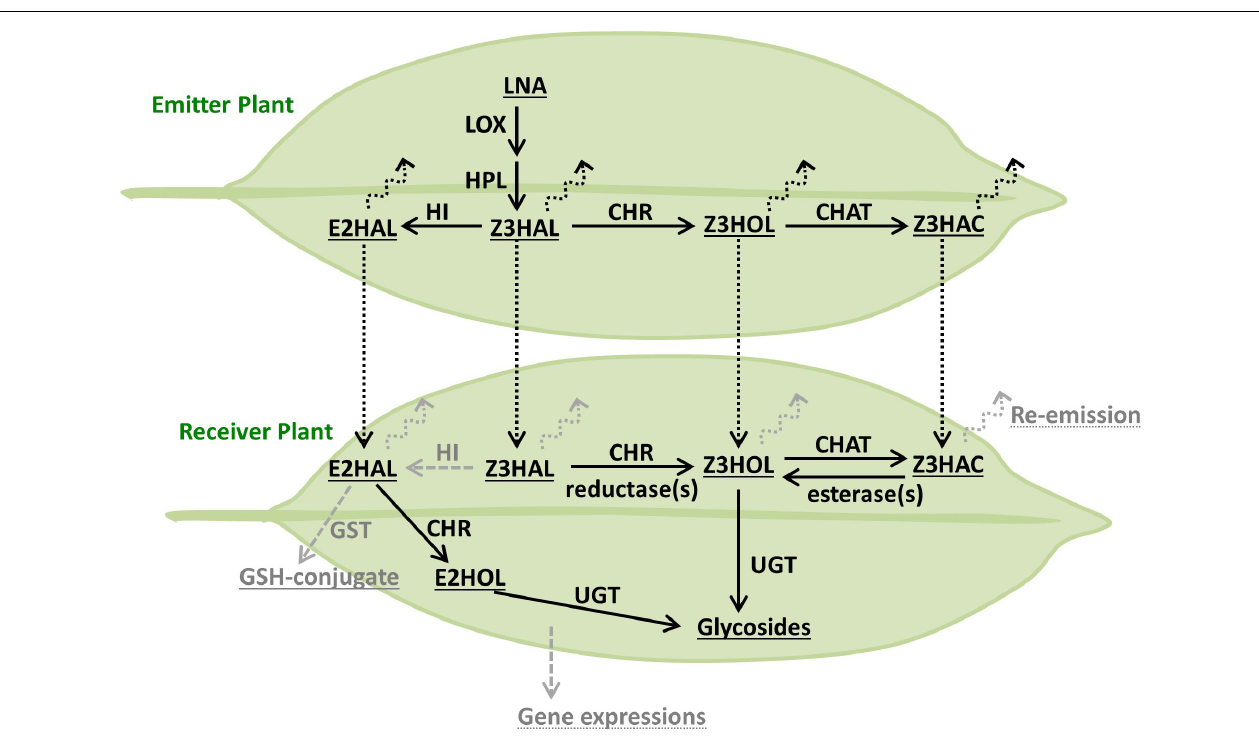
FIGURE 6 | Model of the processing route of green leaf volatiles. The biosynthetic pathway of GLVs originated from LNA is depicted in the emitter plant (top leaf). Processing of exogenous GLVs is depicted in the receiver plant (bottom leaf). The compounds, enzymes, and other processes are described as underlined, plain, and dotted-underlined text, respectively. The enzymatic conversion and airborne transfer are indicated as solid and dotted arrows, respectively. The potential components, which were not found or tested in this study, are shown in